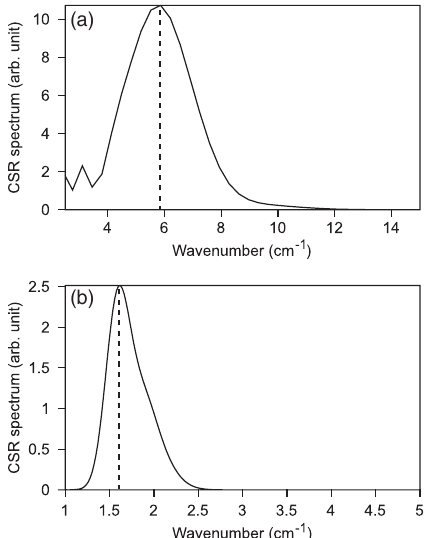
ð ν ; τ Þi in the case of CSR CSRpeak